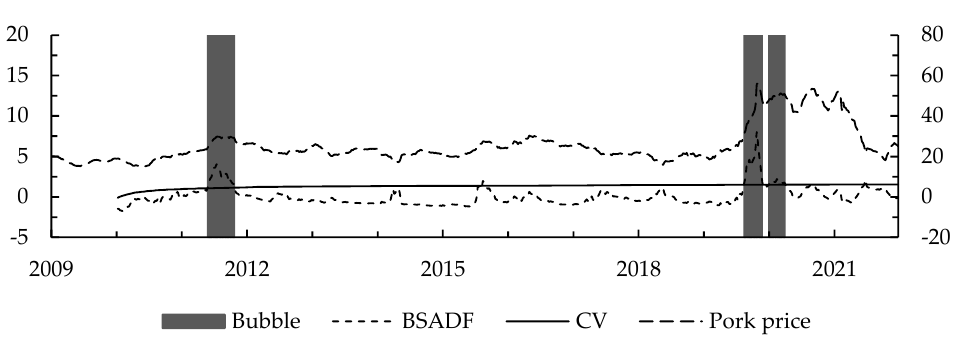
Figure 5. Bubbles in pork prices.